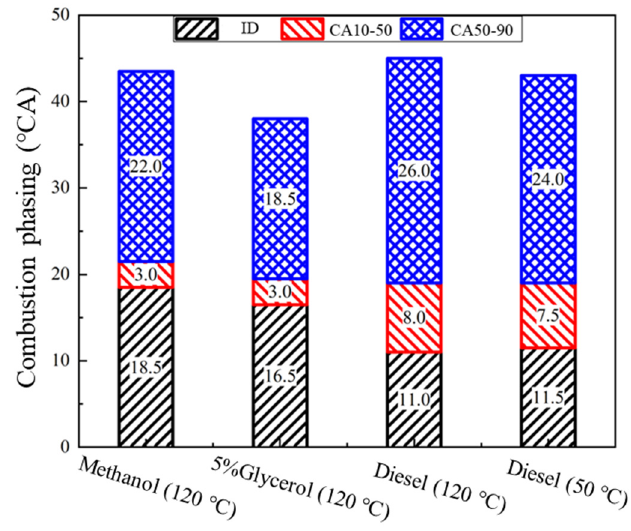
Figure 6. Combustion phasing of different fuels.